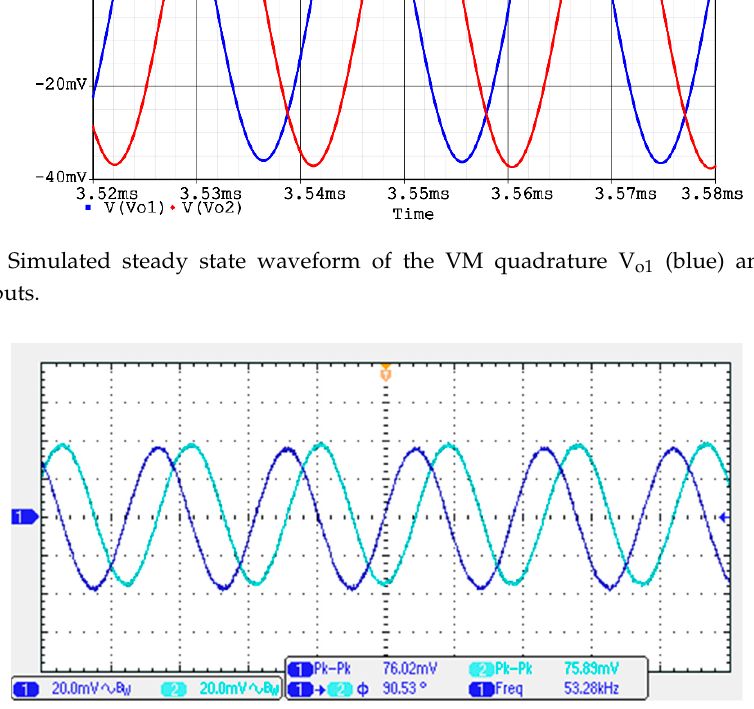
Figure 26. The measured frequency spectrum of the V o2 output terminal.